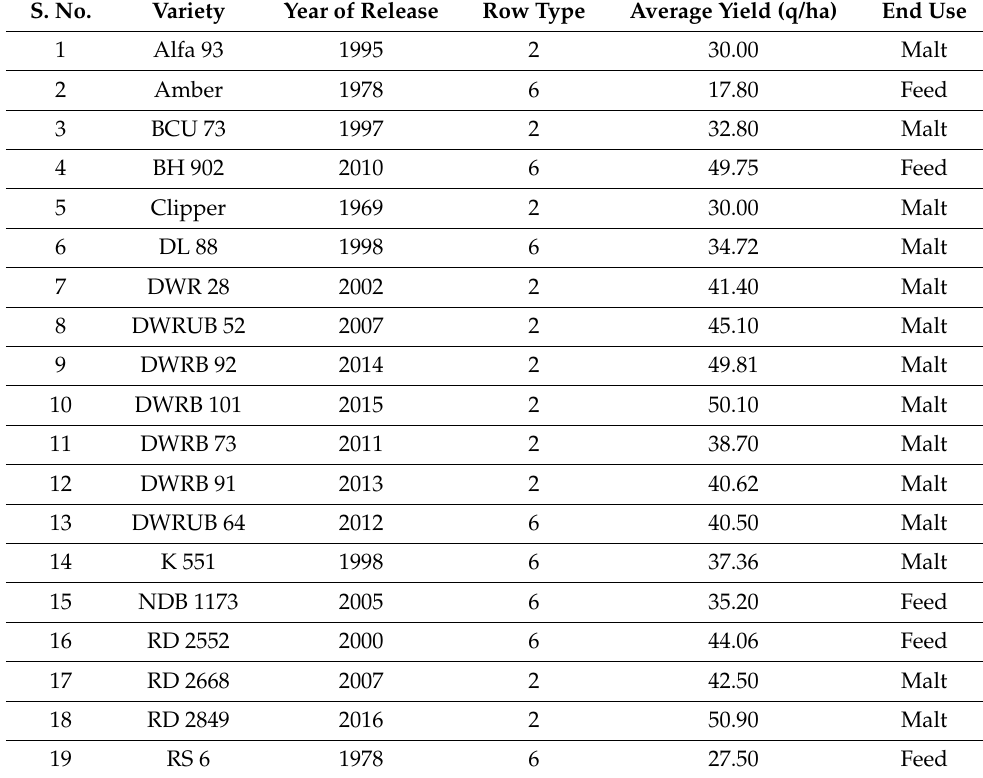
Table 1. Details of genotypes used in the